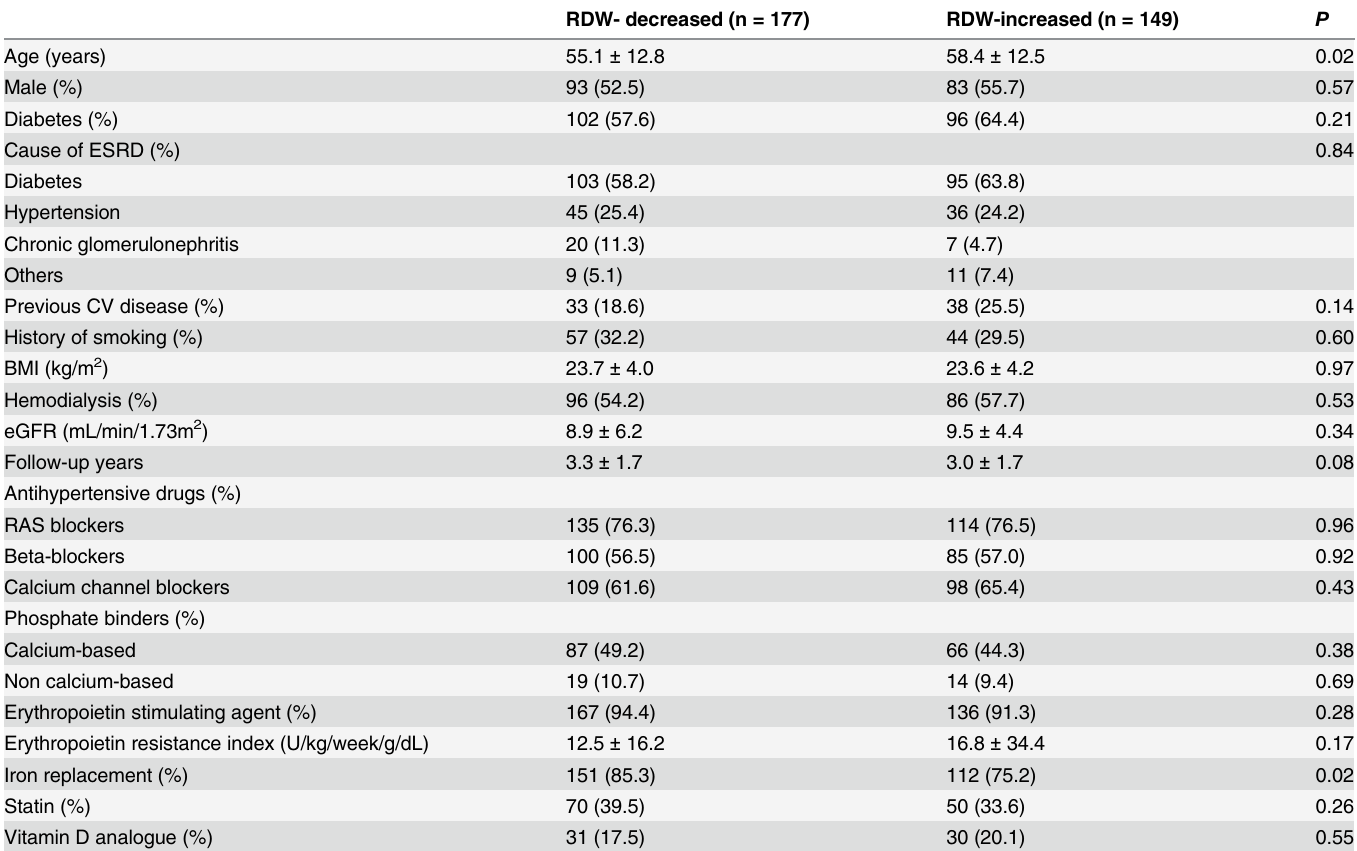
Table 1. Clinical characteristics of the study